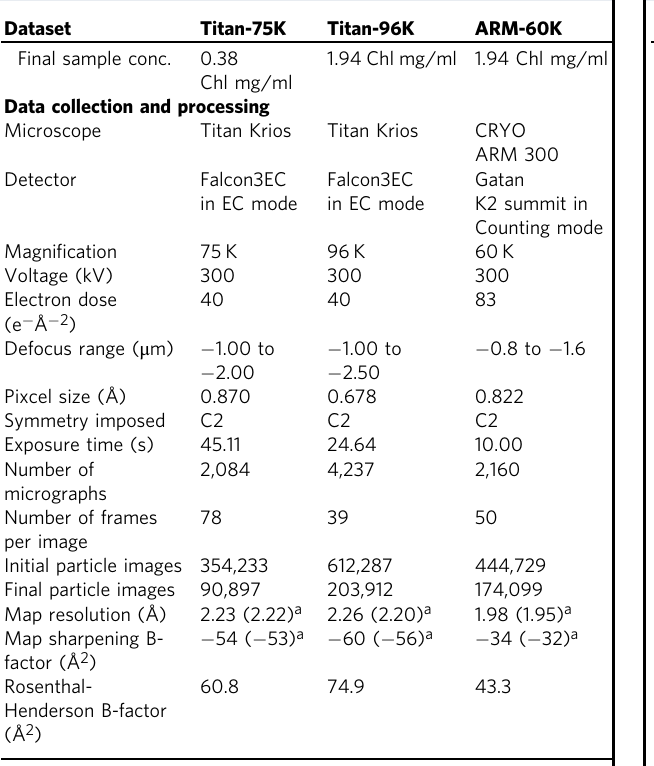
Table 2 Statistics of data collection, processing and re fi